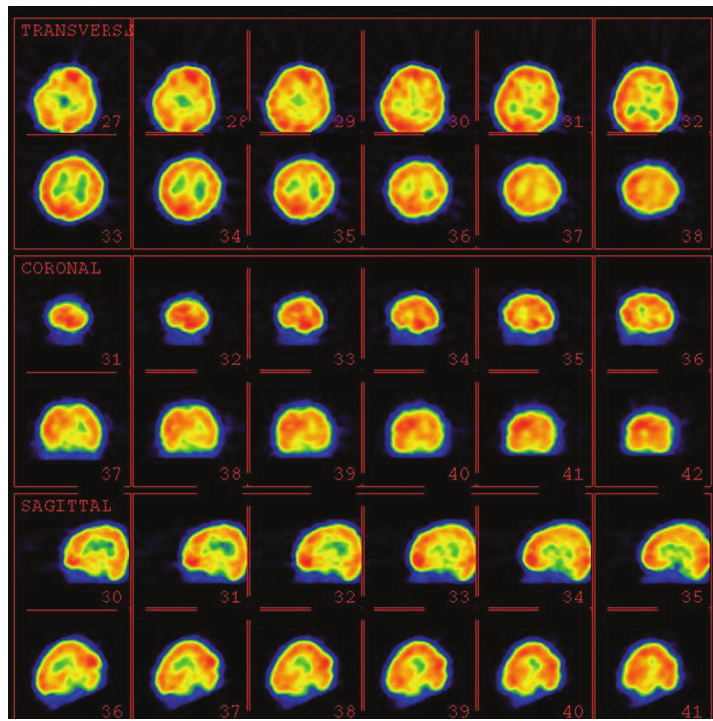
Figure 2: 99mTc-ECD brain perfusion SPECT image of a 6-year-old boy with Landau-Kleffner syndrome (LKS). There is moderate hypoperfusion in the left temporal, left parietal, and left inferior frontal regions and also mild hypoperfusion in the right inferior parietal area. The upper rows indicate transverse 99mTc-ECD SPECT images. The middle rows indicate coronal 99mTc-ECD SPECT images. The lower rows indicate sagittal 99mTc-ECD SPECT